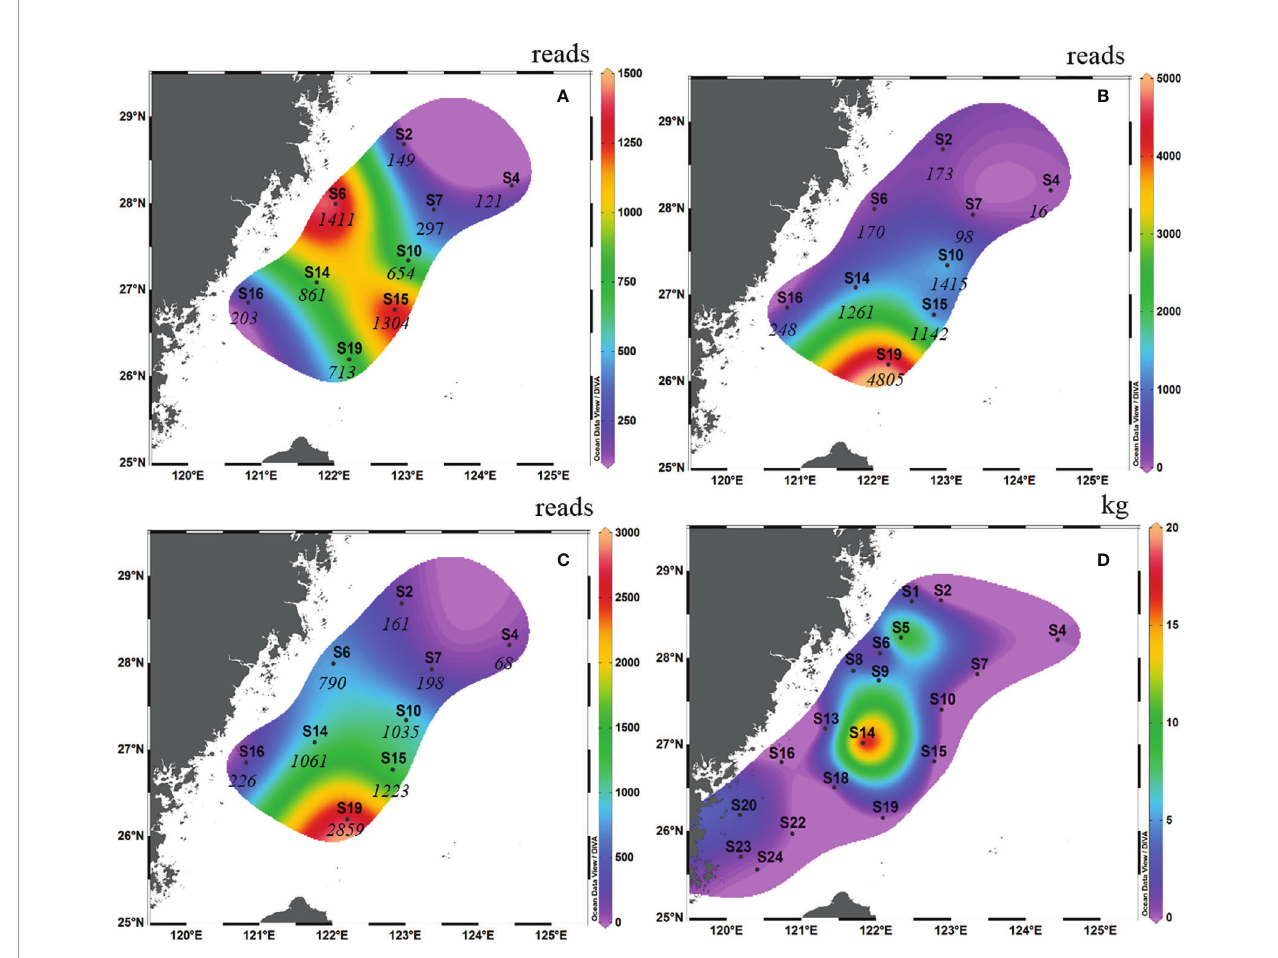
FIGURE 2 | Contour map of Larimichthys crocea in the East China Sea in autumn 2018 based on metabarcoding analysis from surface samples (A) , bottom samples (B) and the average abundance between surface samples and bottom samples (C) , and based on capture biomass from fi shing surveys (D) . The italicized numbers indicate the OTU abundance of L. crocea